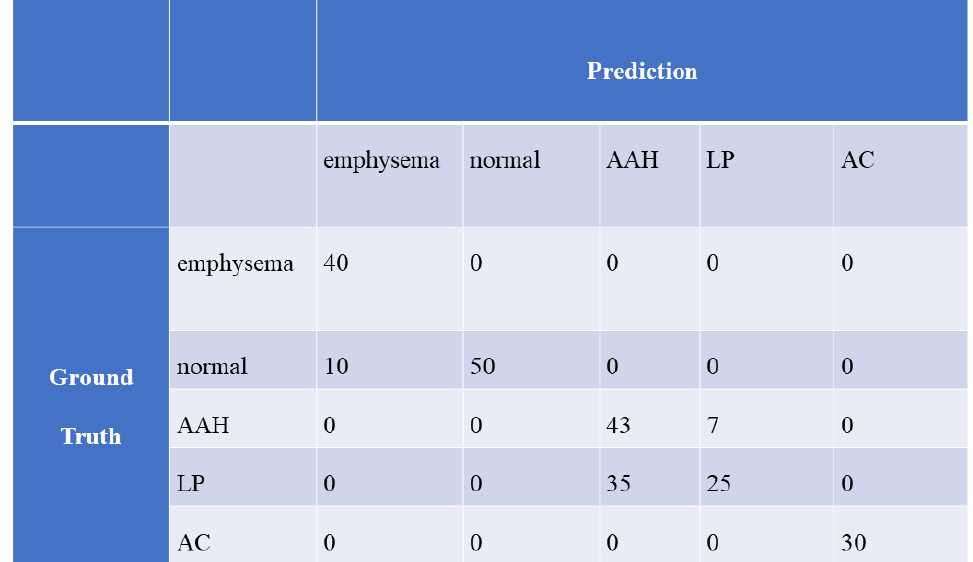
Figure 6. Confusion matrix between the ground truth and prediction obtained with the optimal CAD system for the private dataset.